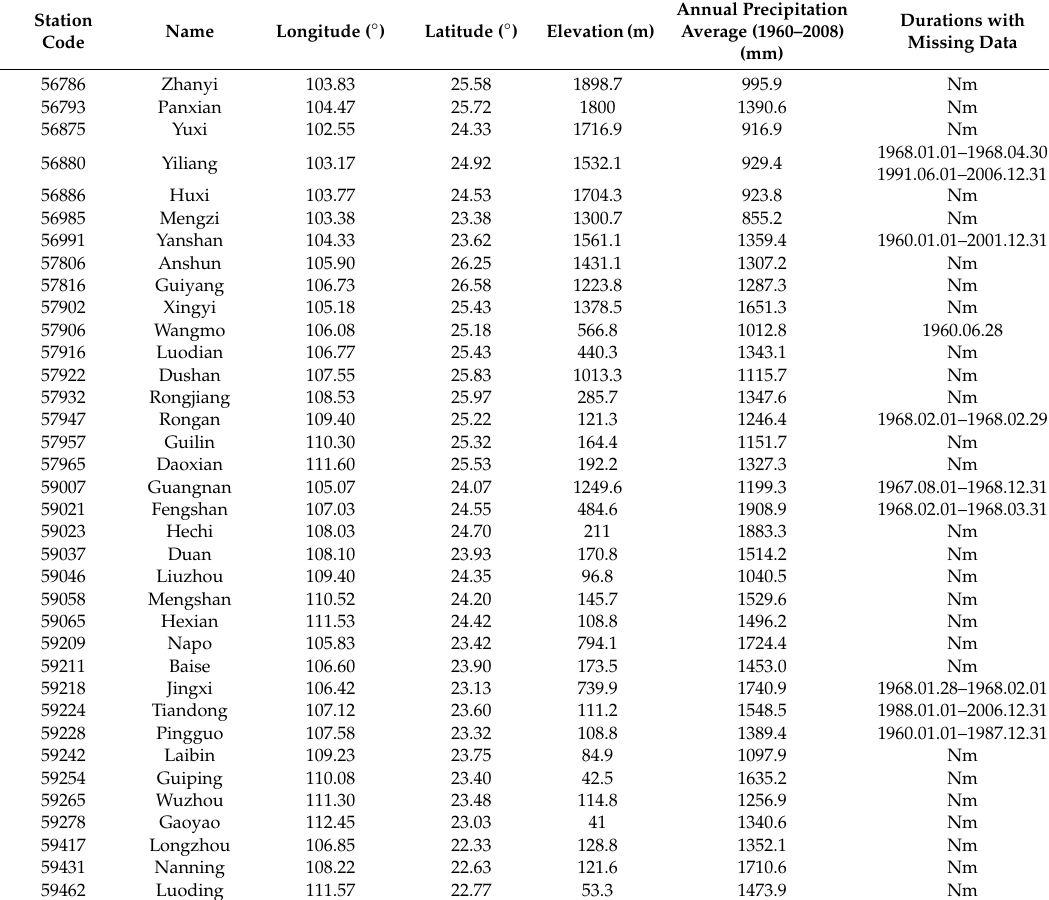
Table 1. Information on the meteorological stations which were collected in this study. Station